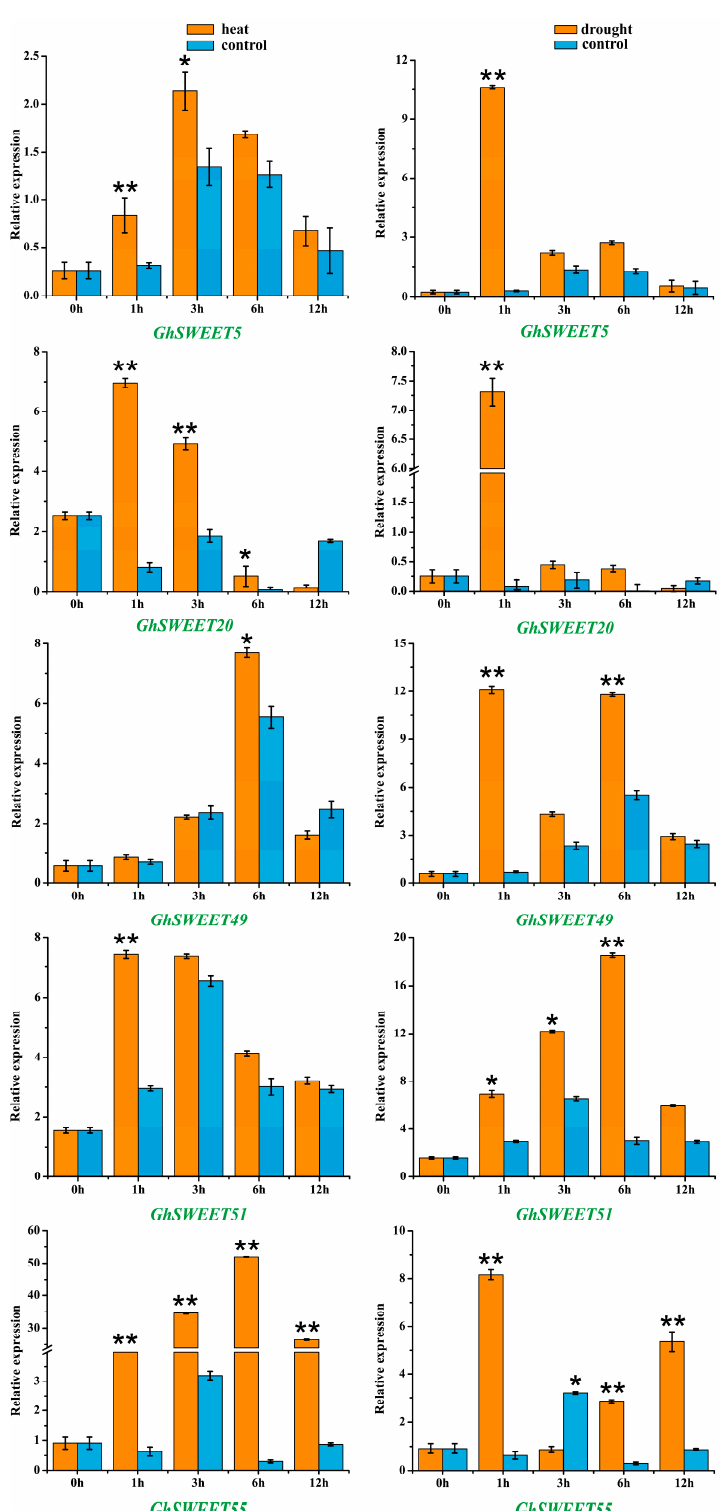
Figure 7. Relative expression levels of the selected GhSWEET genes in response to heat and drought stresses. The GhHis3 was used as an internal control. Relative gene expression levels were calculated based on the 2 −ΔΔ C T method. The mean expression values were calculated on the basis of three independent replicates. Error bars indicate the standard deviations of three independent experiments. The relative expression levels of selected GhSWEET genes after treats were compared with the controls at the same time point. Significant differences were determined by t-test (* p < 0.05; ** p < 0.01).